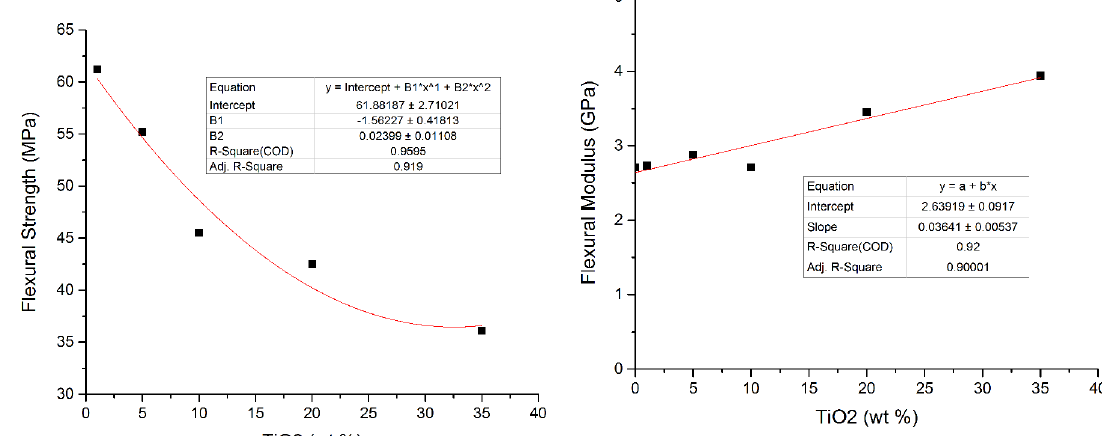
Figure 7. The flexural modulus of elasticity of the TiO